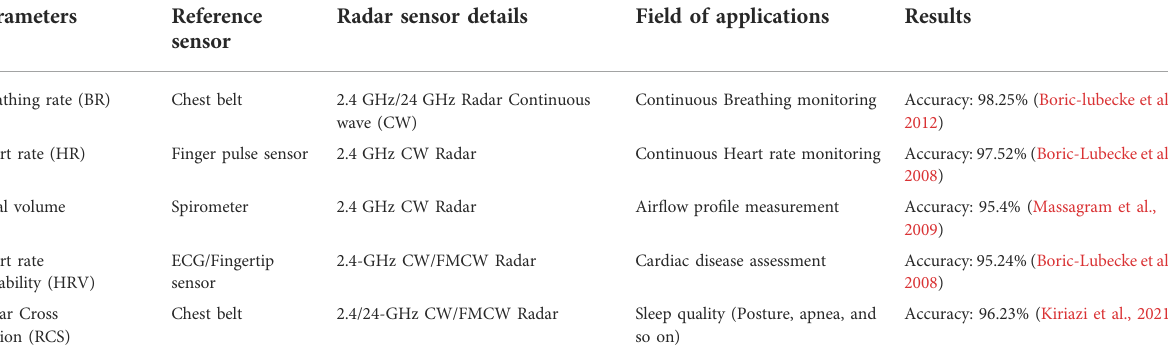
TABLE 2 A comparative analysis of different vital signs parameters extracted by Radar and its accuracy with the traditional